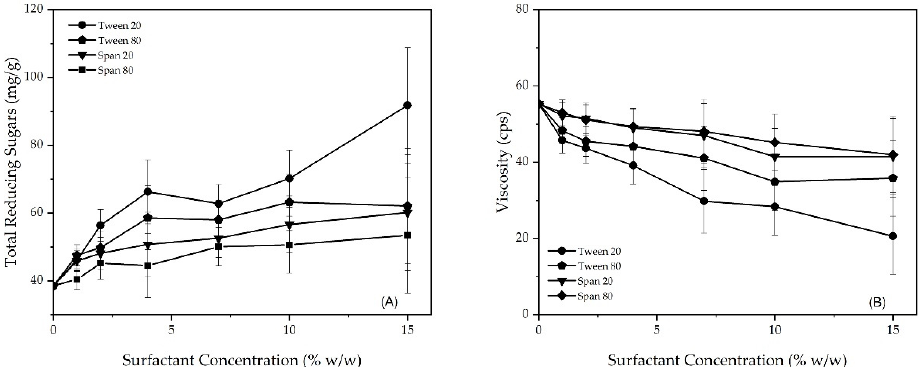
Figure 3. Total reducing sugar ( A ) and viscosity decline ( B ) profile in the chitosan enzymatic hydrolysis for 24 h with various surfactant concentrations.